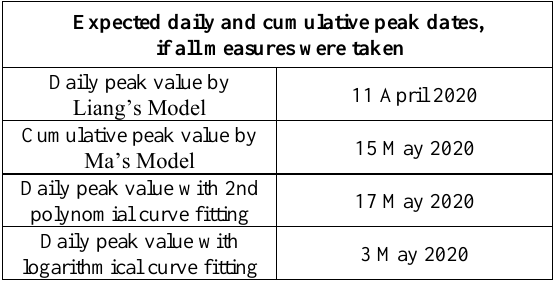
Table 1. Expected daily and cumulative peak